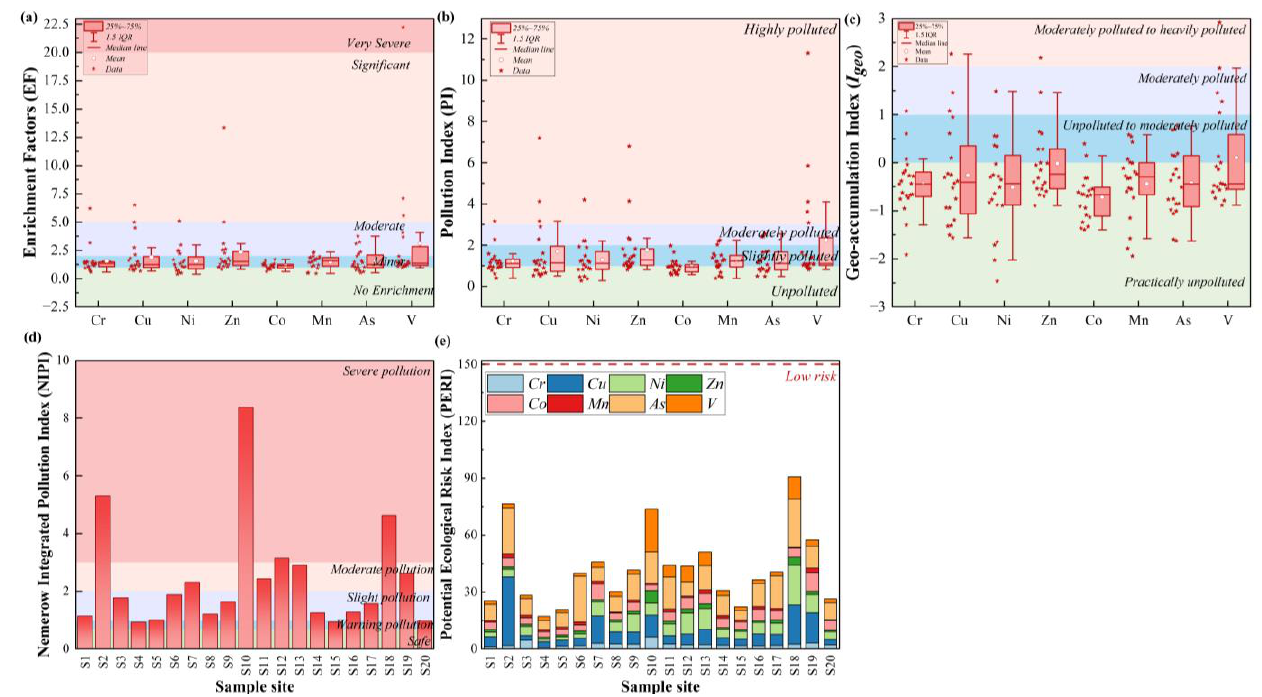
Figure 4. The enrichment factors (EF) ( a ), pollution index (PI) ( b ), geo-accumulation index (I geo ) ( c ), Nemerow integrated pollution index (NIPI) ( d ), and potential ecological index (PERI) ( e ) of metal(loid)s in SNJ soil.